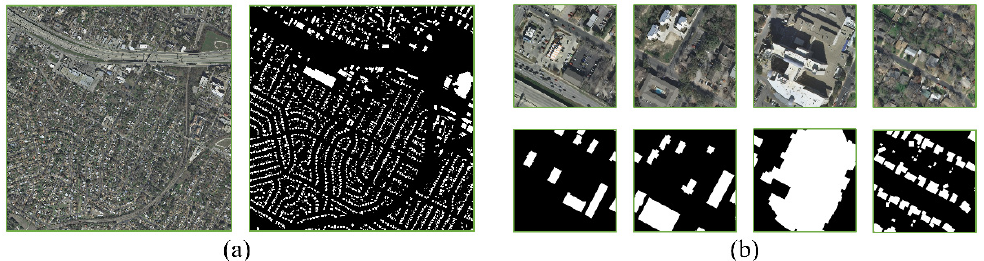
Figure 7. Examples of the images and the ground truth of the INRIA aerial image labeling dataset. ( a ) and ( b ) are the original dataset and the preprocessed image examples, respectively.